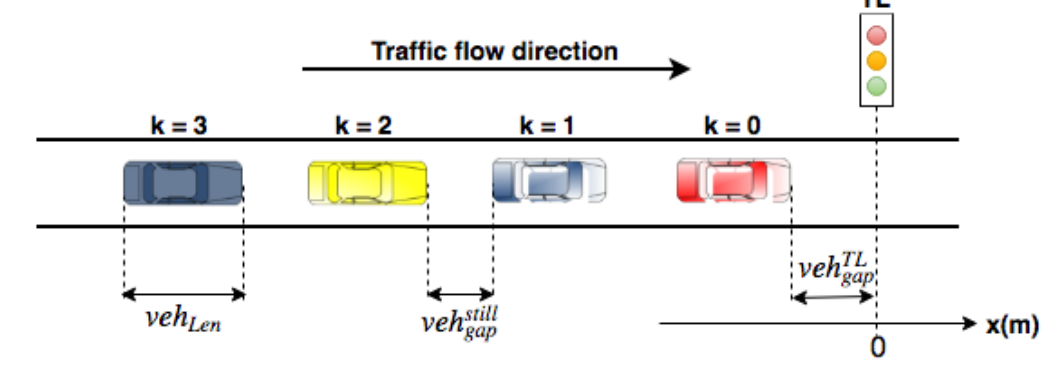
Figure 5. Queue of vehicles behind a Traffic Light (TL).